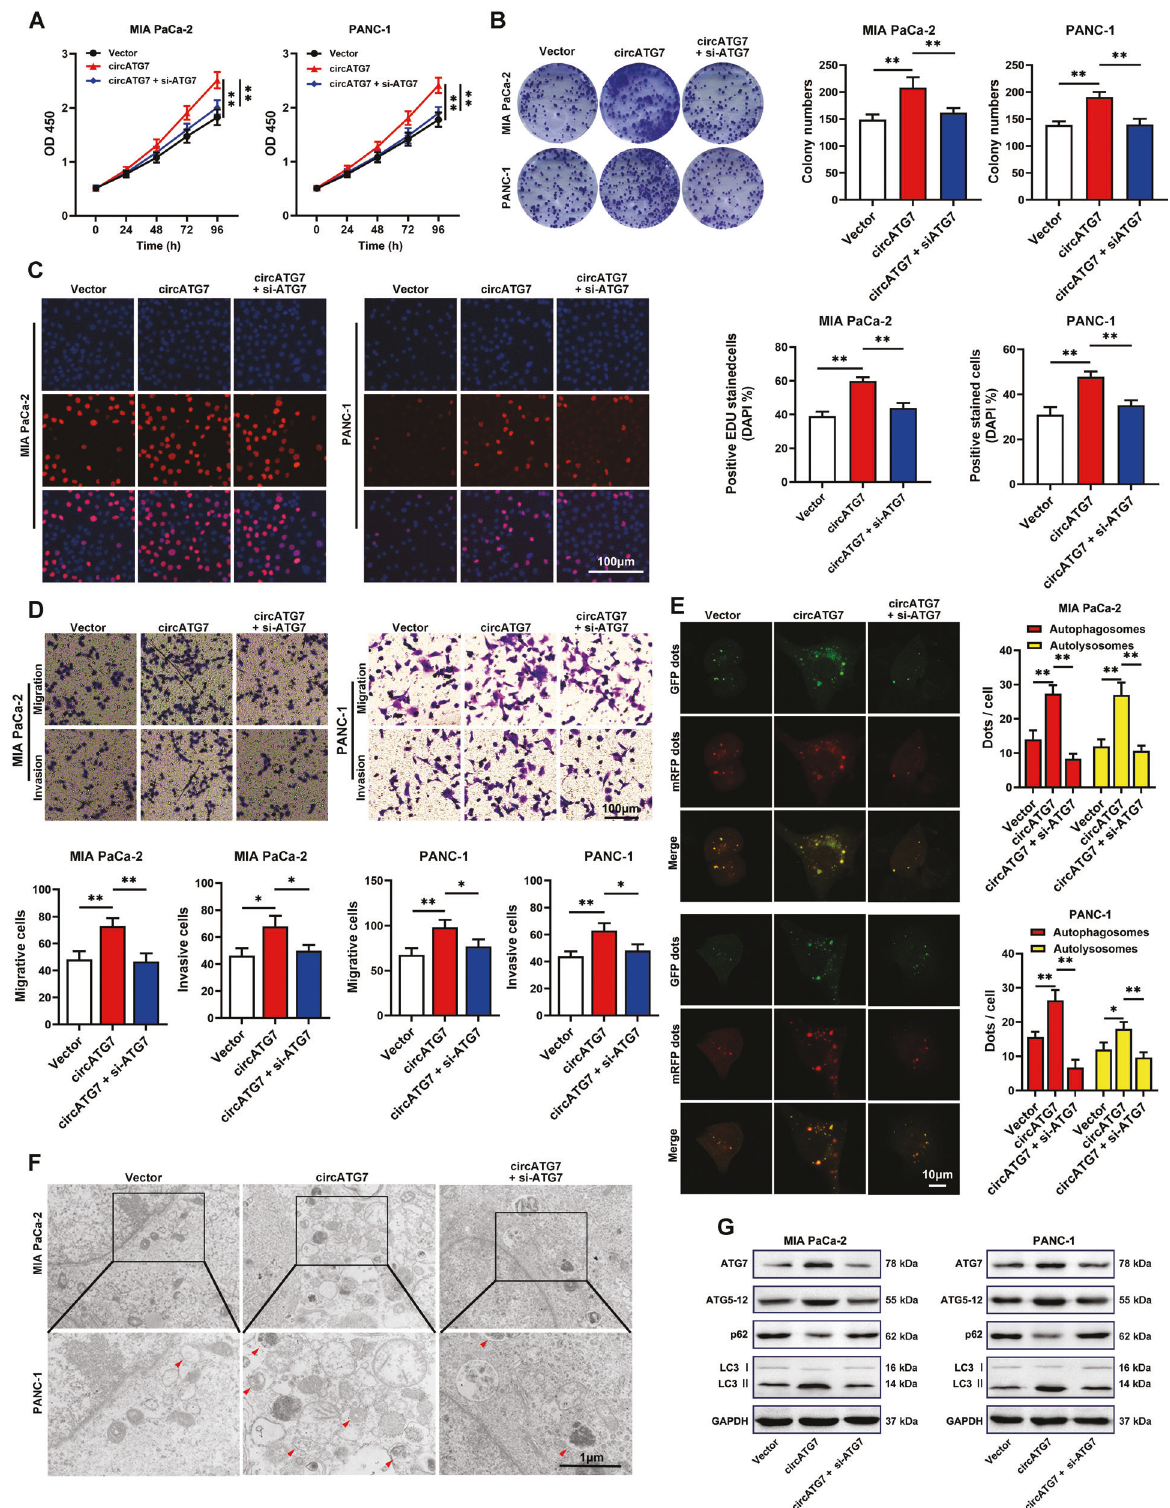
Fig. 4 Knockdown of AGT7 reversed the promotive effects of circATG7 on PC cell proliferation, mobility, and autophagy. PC cells were treated with empty vector, circATG7-overexpressing lentivirus, and circATG7-overexpressing lentivirus plus ATG7 siRNA. A CCK-8 assay was used to determine the rate of PC cell proliferation in each group. B Colony formation assay was used to detect colony formation in each group. C EDU assay was performed to determine the rate of EDU positivity in each group. D Migration and invasion Transwell assays were used to determine the rates of migration and invasion in each group. E , F Confocal and transmission electron microscopy were used to assess autophagy in each group of PC cells. Red arrows represent autophagosomes. G Western blotting was used to detect biomarkers of autophagy in each group, including ATG7, ATG5-12, P62, and LC3. * P < 0.05; ** P < 0.01.